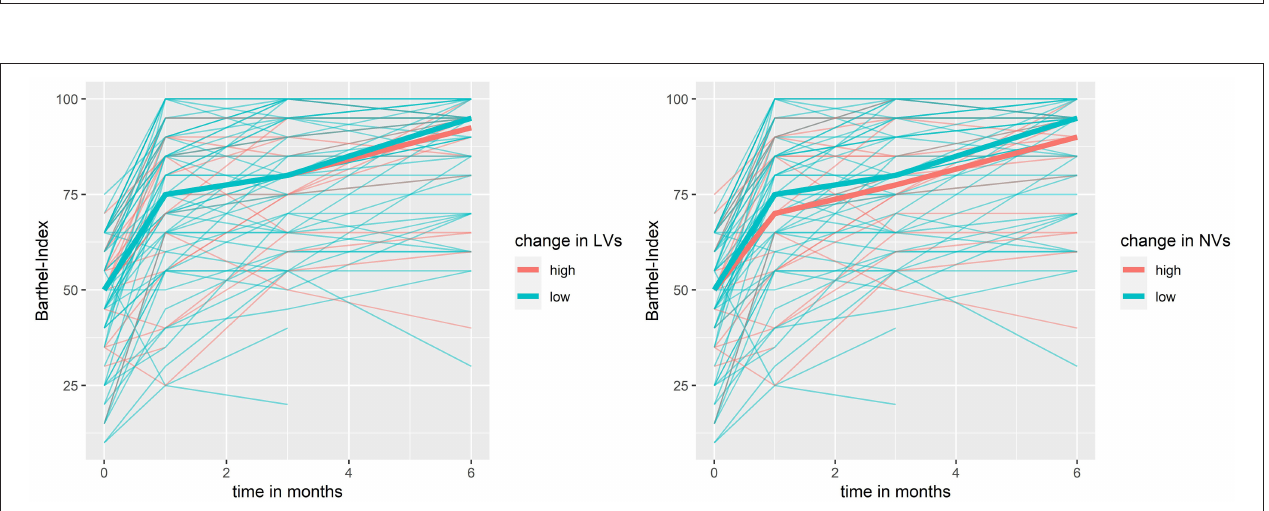
FIGURE 3 | Barthel Index in the first 6 months post stroke by neuronal- and platelet-derived extracellular vesicles at baseline. bold line = median; NV, neuronal-derived vesicles at baseline; PV, platelet-derived vesicles at baseline.